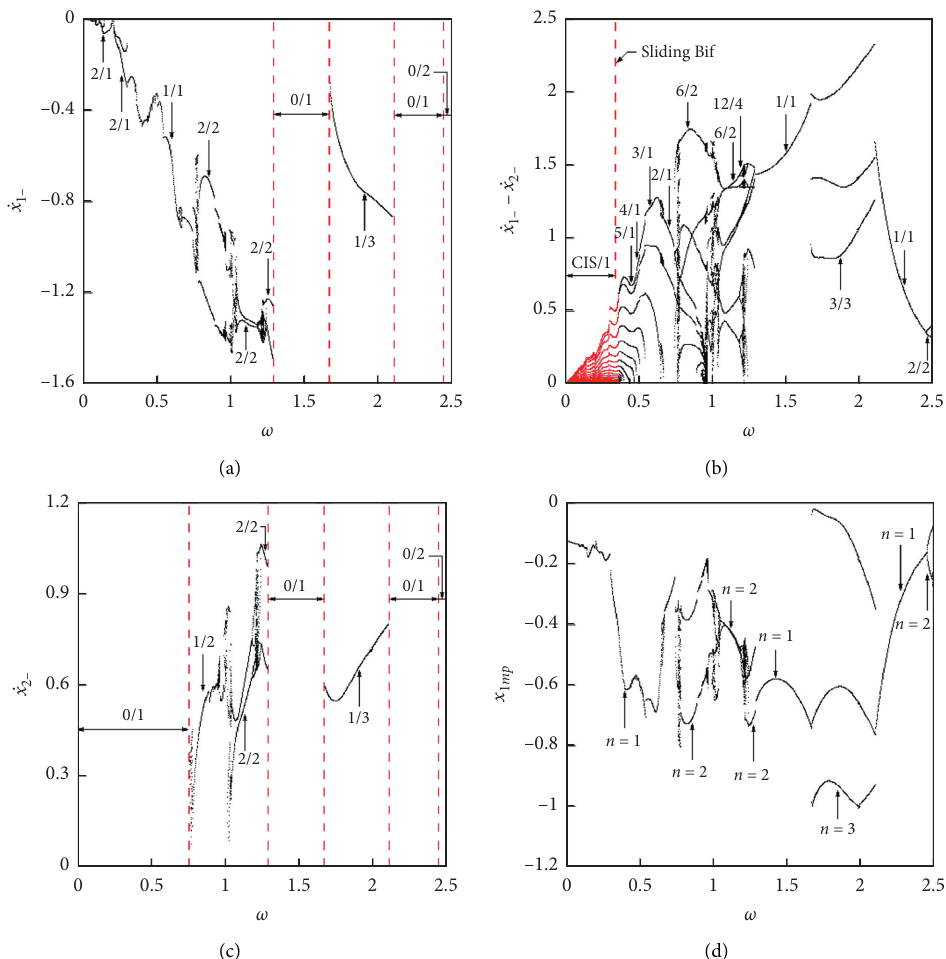
Figure 5: Bifurcation diagrams of the system when δ � 0 . 1. (a) Impact bifurcation diagram at constraint A at constraint A 12 ; (c) impact bifurcation diagram at constraint A 2 ; (d) periodic bifurcation diagrams.